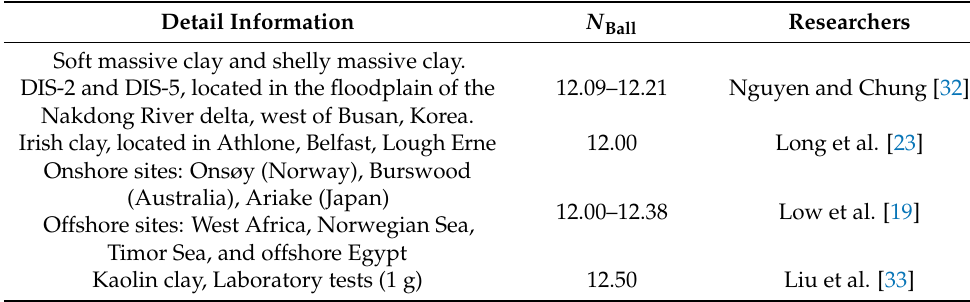
Table 2. Penetration resistance factors ( N Ball ) from different studies. Detail Information N Ball